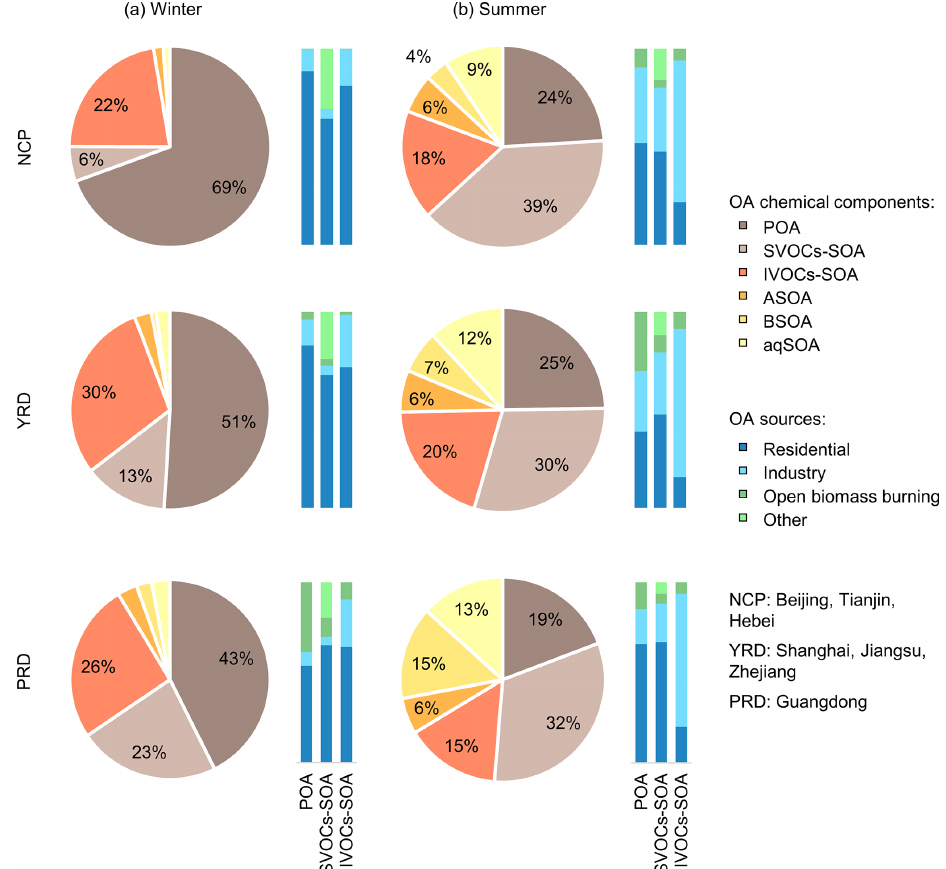
Figure 7. Seasonal mean mass fractions of OA components and the sources of POA, SVOCs-SOA, and IVOCs-SOA in NCP, YRD, and PRD in (a) winter and (b) summer simulated by the Cp_R1 + 2 + 3